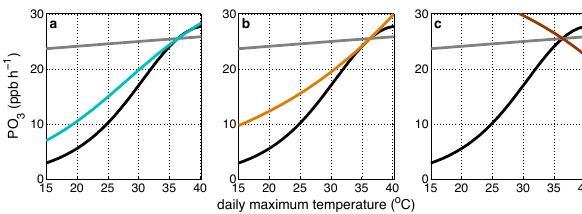
Fig. D1. P O 3 (ppbh − 1 ) at weekday NO x versus daily maxi- mum temperature ( ◦ C). The solid black curves are the same as in Fig. 7a–c. The gray curves are P O 3 at the high tempera- ture average (36.4 ◦ C) VOCR, P HO x , and NO/NO x values with rate constants that are allowed to be temperature dependent. (a) P O 3 with temperature-dependent VOCR (NO/NO x and P HO x are constant). (b) P O 3 with temperature-dependent P HO x (VOCR and NO/NO x are constant). (c) P O 3 with temperature-dependent NO/NO x (VOCR and P HO x are